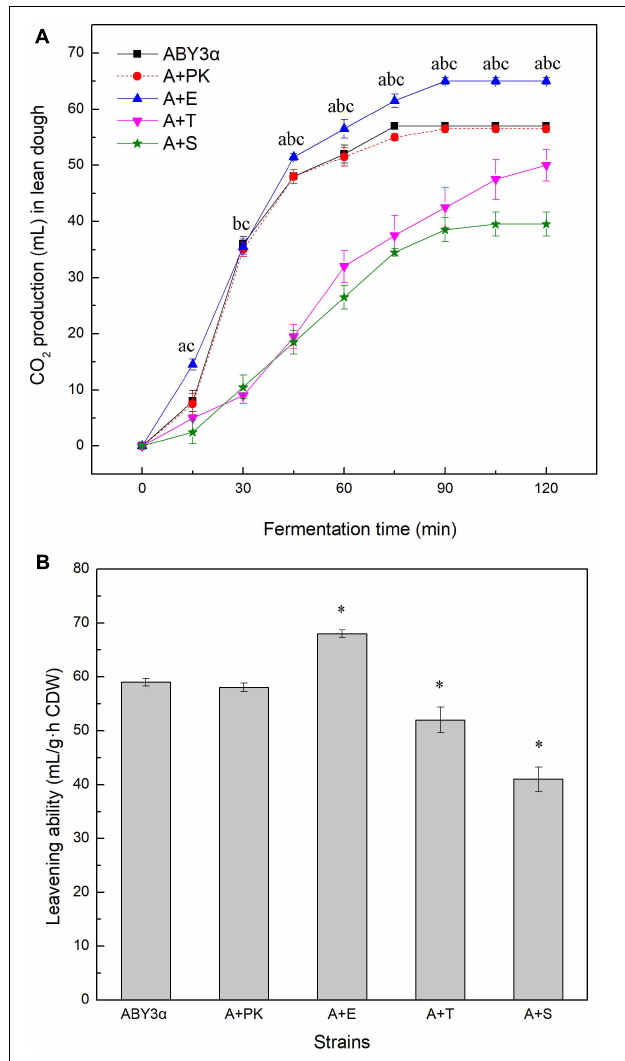
FIGURE 4 | CO 2 production of the strains carrying genes overexpression in lean dough. (A) Mixed dough was placed into a graduated cylinder, and CO 2 amounts were recorded at 30 ◦ C for 120 min. Significant differences of the transformants A+E, A+T, and A+S to the parental strain were confirmed at a p < 0.05, b p < 0.05, and c p < 0.05, respectively. (B) Leavening ability was determined by CO 2 production per hour per gram (dry weight) of yeast cells. Significant differences of the transformants to the parental strain were confirmed at ∗ P < 0.05. ABY3 α , the parental strain; A+PK, the strain carrying the vector Yep-PK used as a blank control to demonstrate any possible effect of the empty vector; A+E, the transformant carrying ELM1 overexpression; A+T, the transformant carrying TOS3 overexpression; A+S, the transformant carrying SAK1